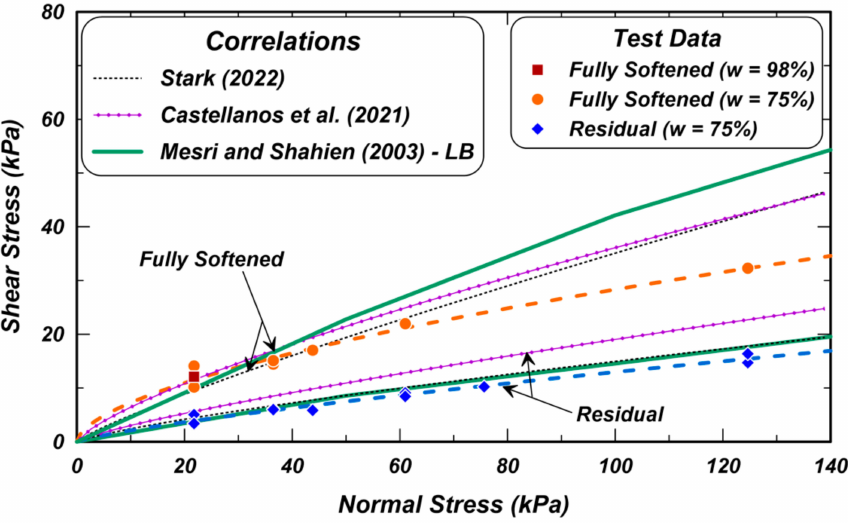
Figure 3. Ring shear results for both fully softened and residual strengths from samples tested at normal stresses between 22 and 125 kPa. The test results are compared with correlations from Stark [40], Castellanos et al. [41], and Mesri and Shahien